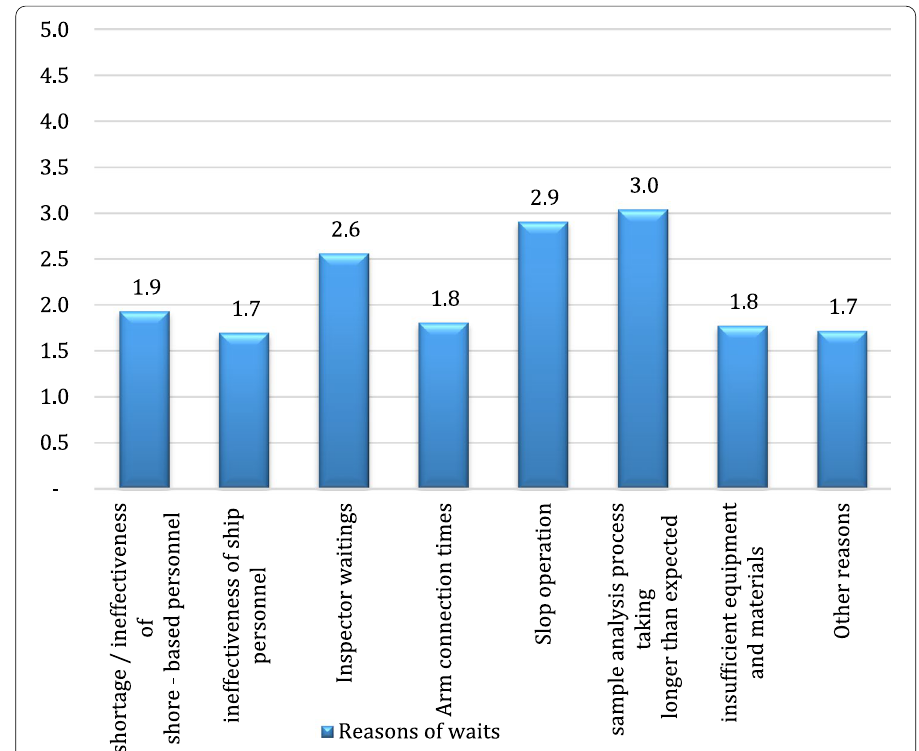
Fig. 3 The reasons for the waits during the preparation period before handling